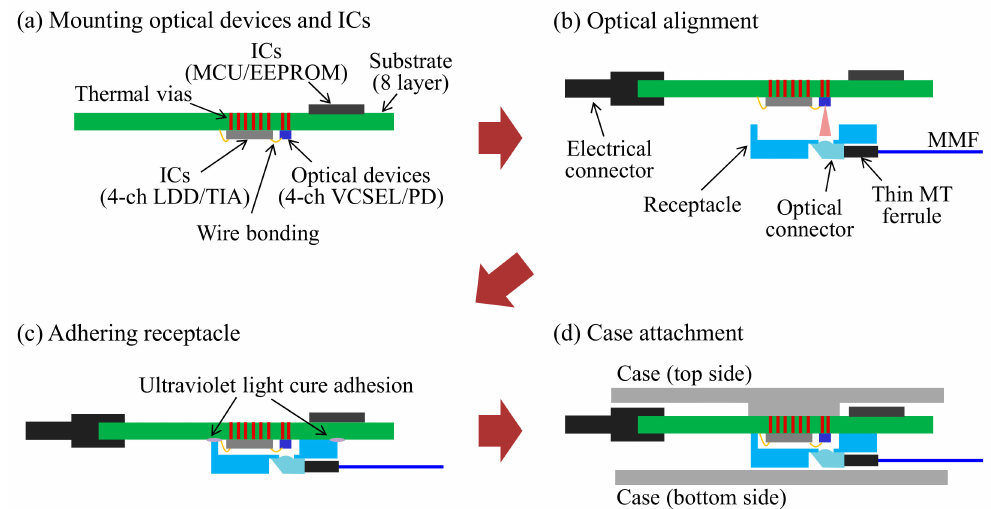
Figure 5. Fabrication procedure of proposed AOC. MCU, micro control unit; LDD, laser diode